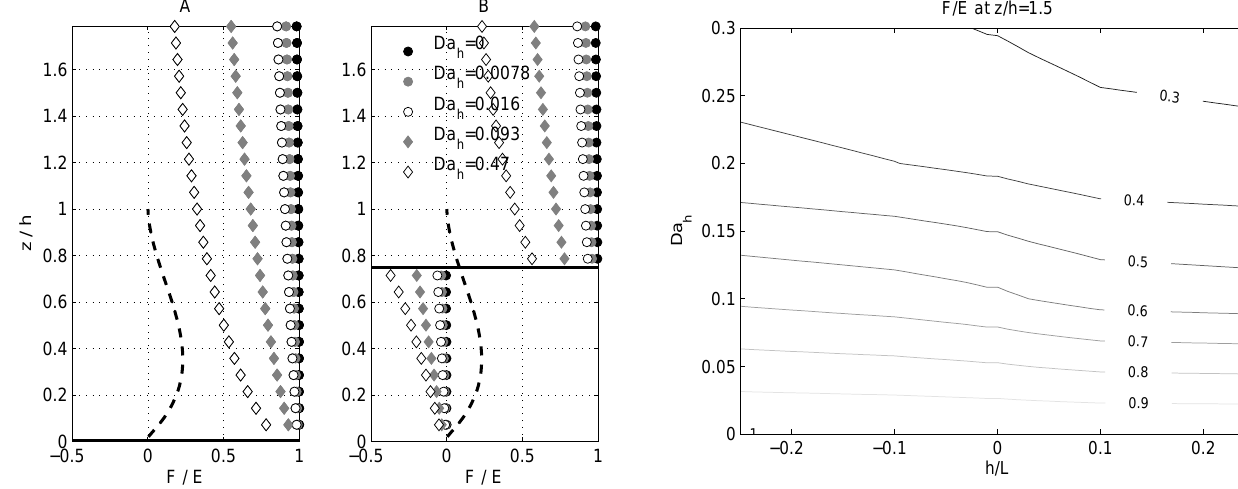
Fig. 4. The flux-to-surface-exchange ( F / E ) ratio profiles calculated using foliage distribution (dashed black line) typical for spruce for- est. The vertical profile of oxidation rate is constant and the source is either at the ground level (Panel A ) or at the height corresponding to the displacement height of the Scots pine forest.